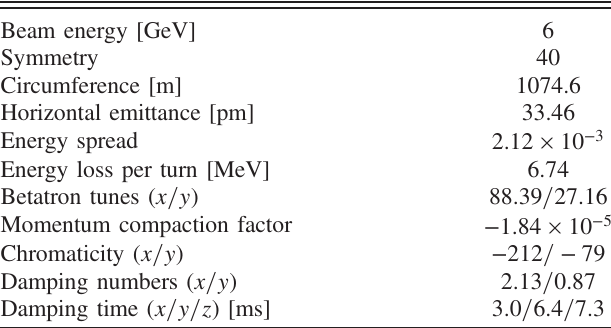
TABLE IX. Main parameters of 6 GeV light source based on mTME